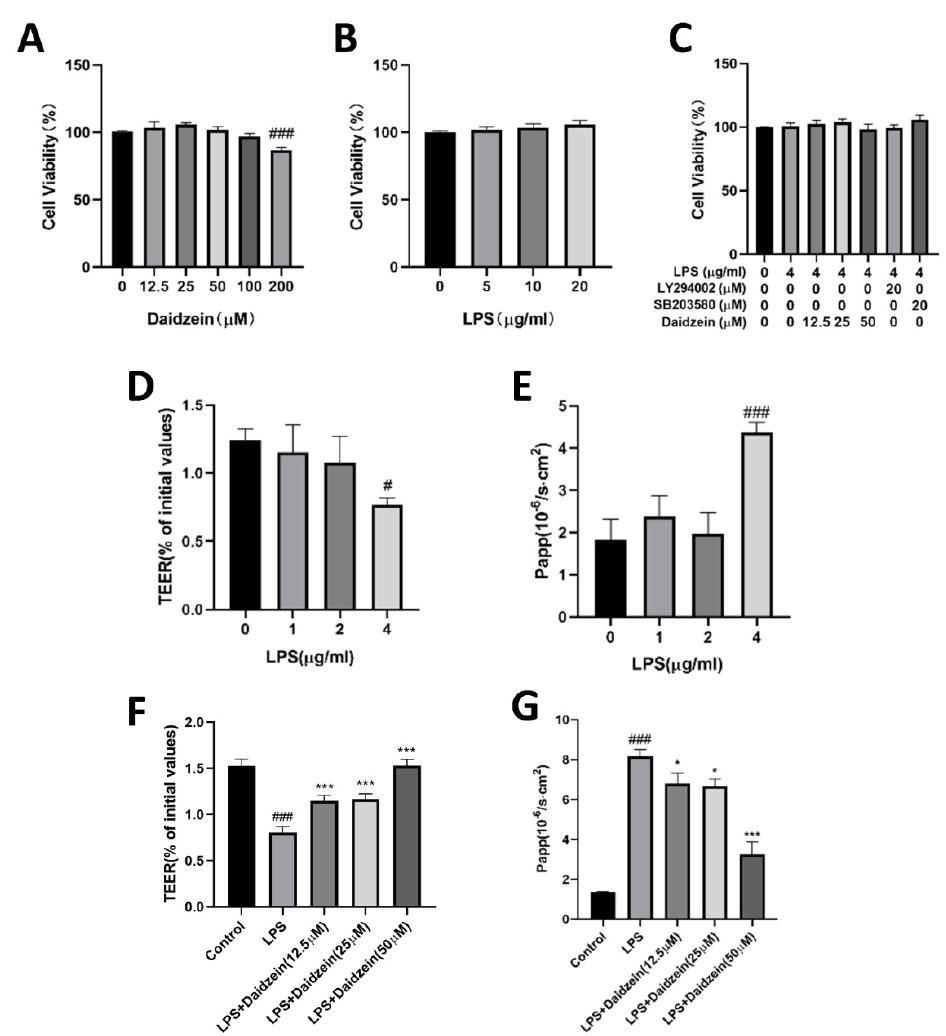
Figure 2. Daidzein improved lipopolysaccharide (LPS)-induced integrity disruption in Caco-2 cell monolayers. ( A ) Cytotoxicity of LPS for 24 h. ( B ) Cytotoxicity of daidzein for 24 h. ( C ) Cytotoxicity of different administration treatments for 24 h. ( D , E ) TEER and FD4 flux of different concentrations of LPS. ( F , G ) TEER and FD4 flux of different concentrations of daidzein (mean ± SD, n = 3), * p < 0.05, and *** p < 0.001 versus LPS-treated alone. # p < 0.05, ### p < 0.001 versus 0 dose treatment or control group.